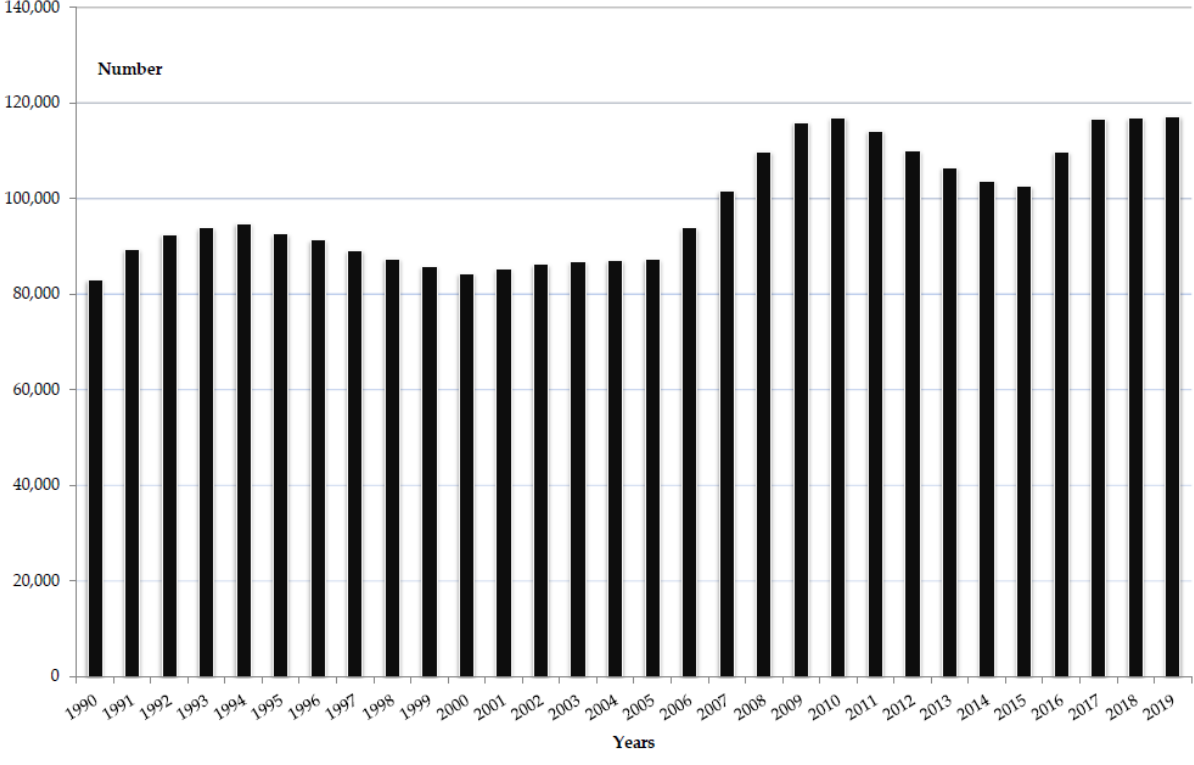
Figure 1. The number of cholera deaths in the world, 1990–2019 (Source of data Ref. [10]). In both sexes in 2019, most cholera-related deaths (92,790; 79.2% of the total) were recorded in the African Region, followed by the Eastern Mediterranean Region (15,247; 13.0%) (Figure 2). The differences in cholera deaths by region between males and females are less obvious. Less than 1% of the total cholera deaths occurred in the Region of Americas and European Regions.